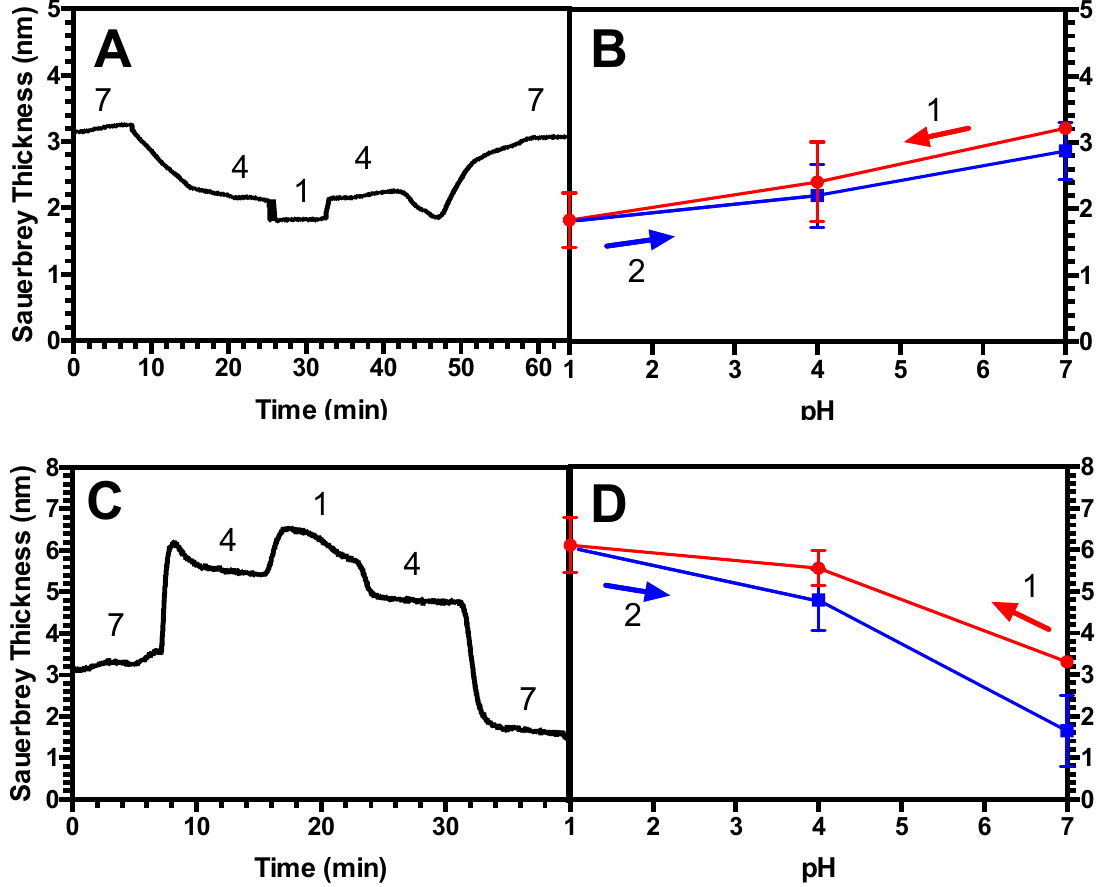
Figure 5. The same as Figure 2, except for a 14 kDa PAA brush; ( A , B ) are otherwise the same as in Figure 2, and in ( C , D ) 10 kDa PEI is used at grafting density σ = 0.06 in 100 mM KCl. Error bars represent the standard deviation for N = 3. Table 2. Summary of experimental findings for PAA brushes and LbL bilayers (PAA/PEI) for vari- ous chain lengths and grafting densities. ** and the yellow color indicate intermediate cases where slow approach to equilibrium suggests that hysteresis would be present at short times (less than 5 min) but becomes small at longer times (tens of minutes).